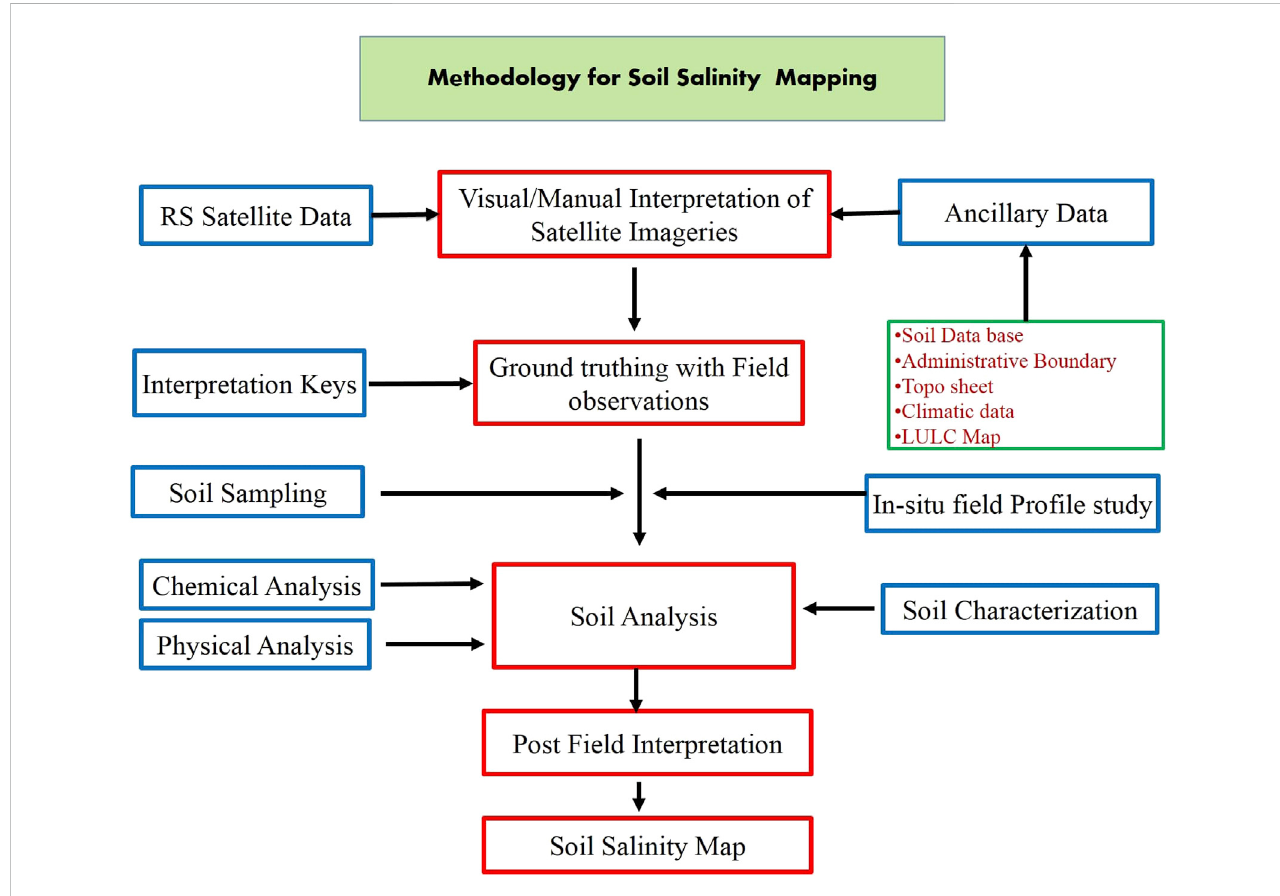
FIGURE 4 Methodology for soil salinity mapping (Abuelgasim and Ammad, 2019; Taghadosi et al.,